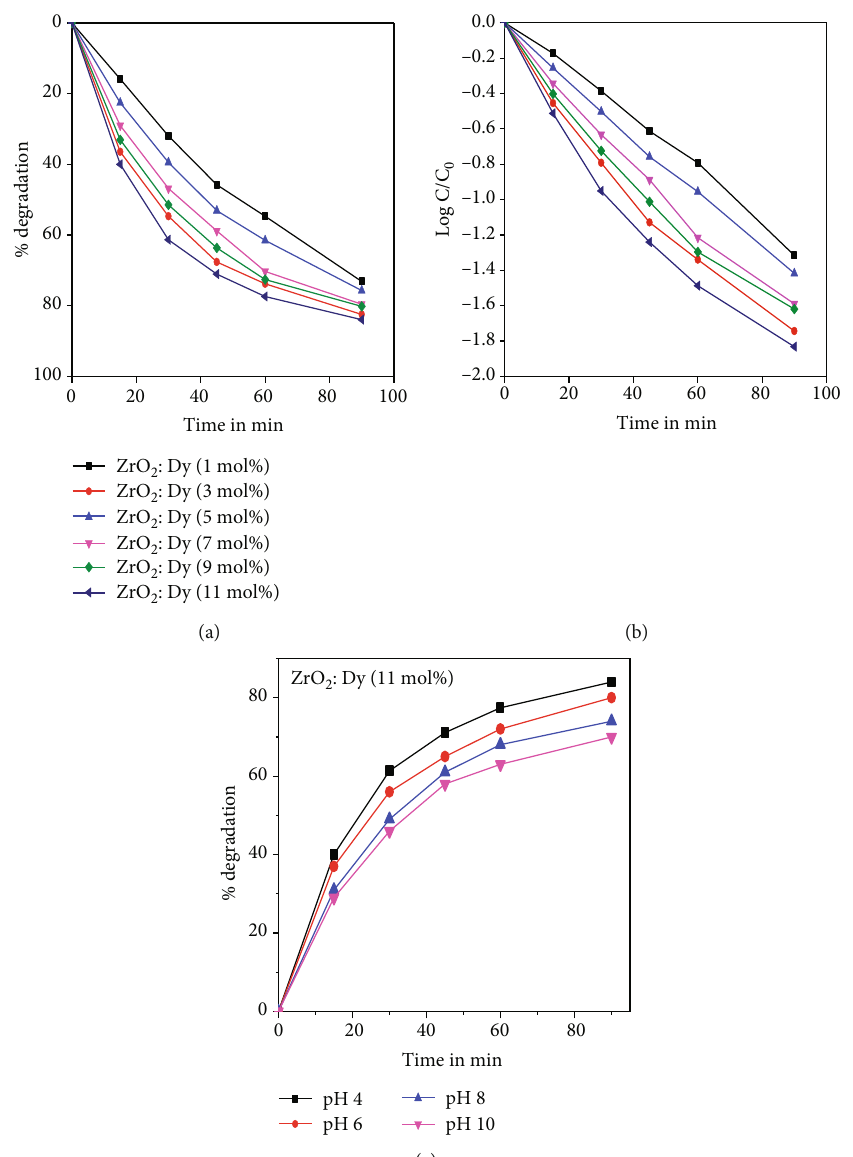
Figure 8: (a) Percentage degradation and (b) C/CO for the decolorization of acid red 88 dye under UV light illumination. (c) E ff ect of pH on photocatalytic degradation of ZrO :Dy (11 mol%) 2